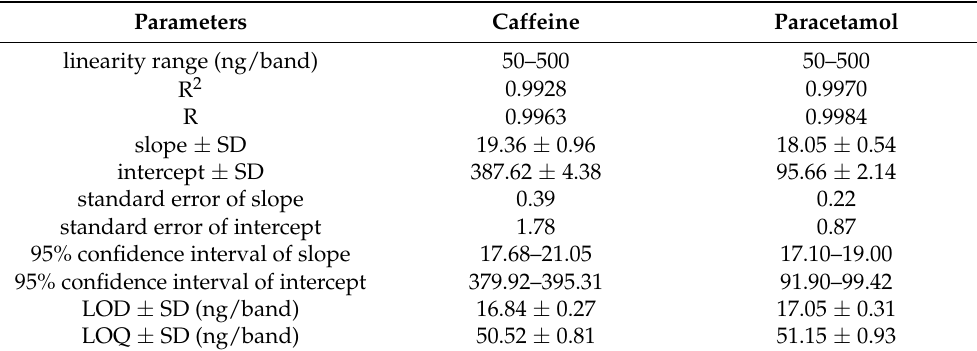
Table 1. Results of the linear regression analysis for the simultaneous determination (SMD) of caffeine and paracetamol using the greener normal-phase high-performance thin-layer chromatography (HPTLC) method (mean ± SD; n = 6).